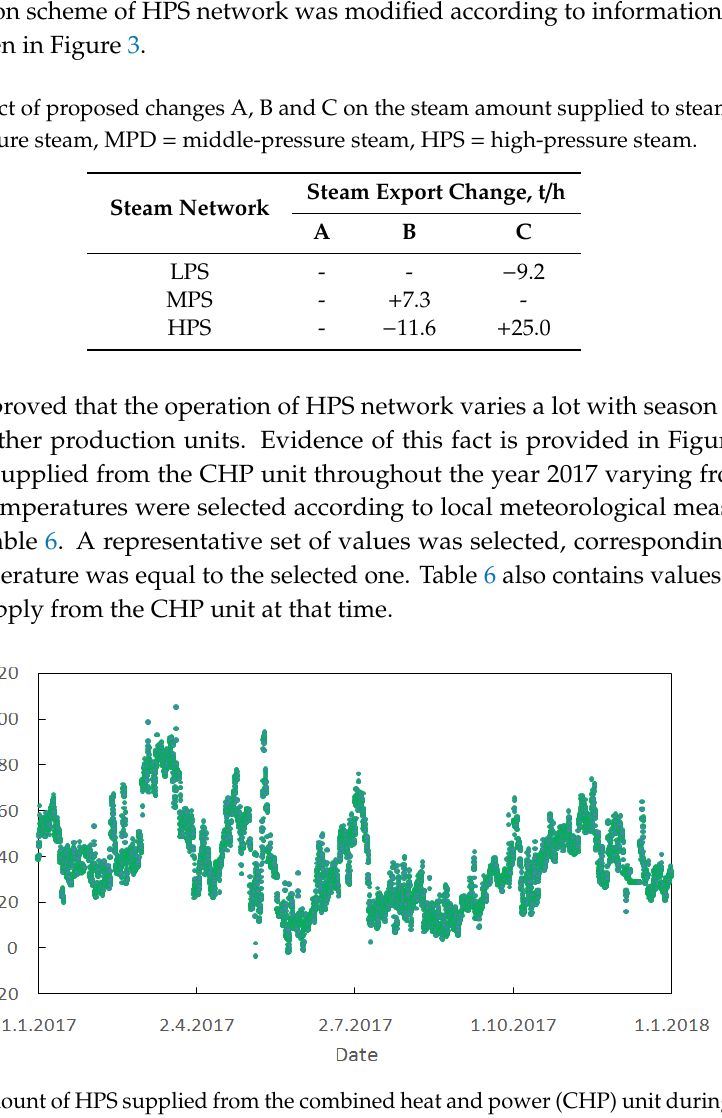
Figure 3. A part of simplified simulation scheme of HPS network after implementation of proposed changes (S = steam supplier, C = steam consumer; existing connection of main pipelines = dot-dashed line, new connection of pipelines = dashed line).